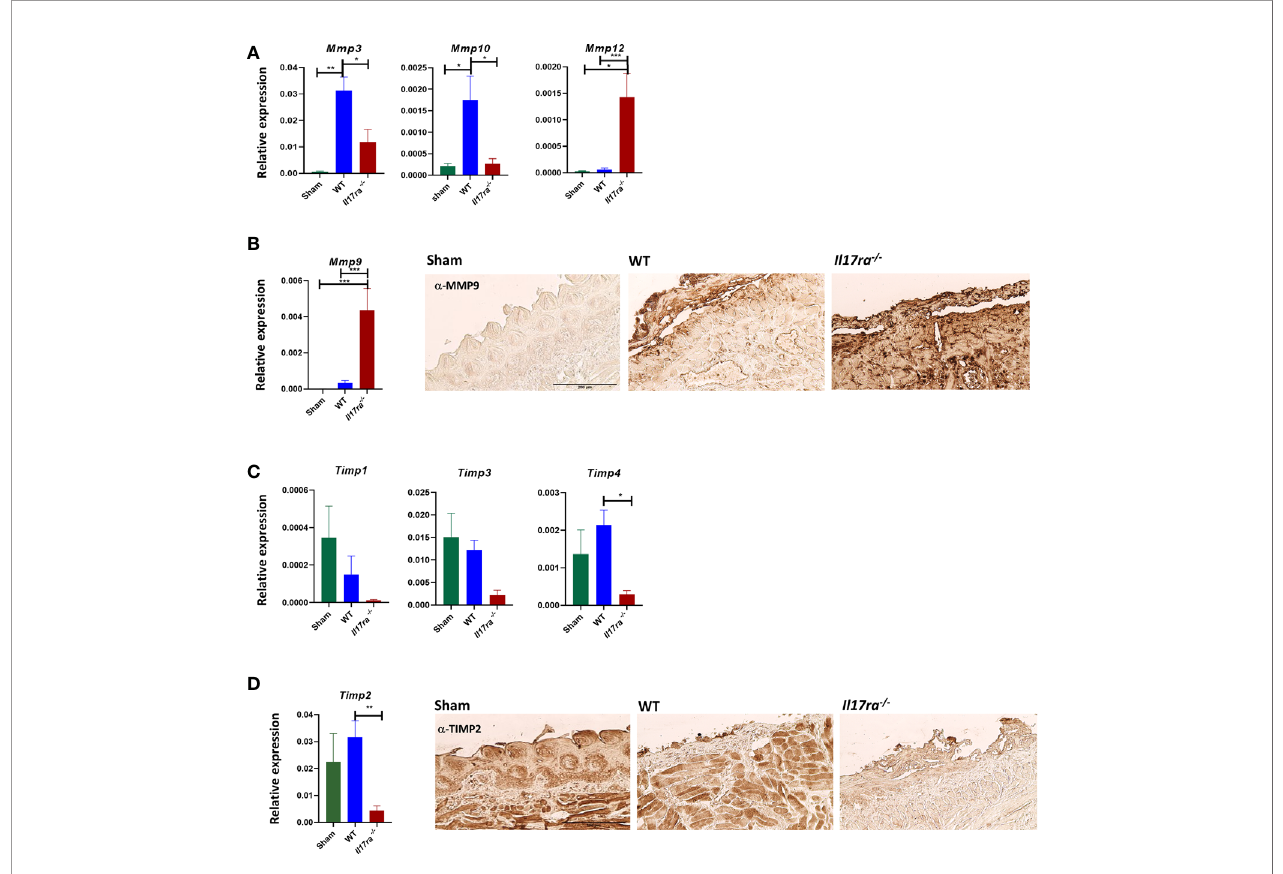
FIGURE 5 | The absence of IL-17RA is associated with dysregulated proteases and inhibitors. (A, C) Gene expression relative to GAPDH of proteases and inhibitors on D11 (N = 3 – 5 per group). N = at least fi ve per group. Mmp3 and Mmp10 , and Timp1,2,3,4 analyzed by ANOVA with Tukey ’ s post hoc , Mmp12 analyzed by Kruskal – Wallace and Dunn ’ s multiple comparison test. Data pooled from at least 3 experiments. (B, D) IHC for MMP9 and TIMP2 from the ulcer boundary zone in the distal tongue. Scale bar, 200 m M. Data shown as means ± SEM, (*P < 0.05, **P < 0.01, ***P <